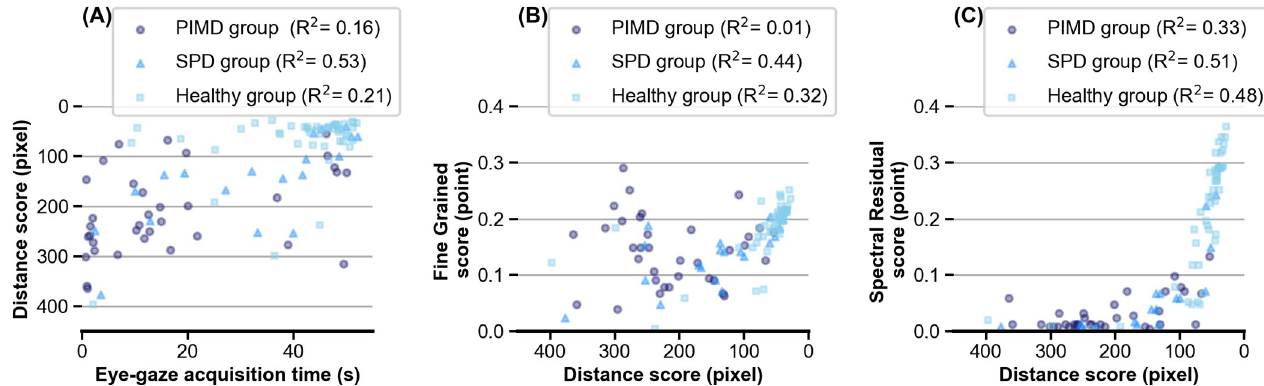
Fig 9. Relationship between distance score and eye-gaze acquisition time or saliency scores. (A) The relationship between eye-gaze acquisition time and distance score. (B) The relationship between distance score and fine-grained score. (C) The relationship between distance score and spectral-residual score. PIMD, profound intellectual and multiple disabilities; SPD, severe physical disabilities.